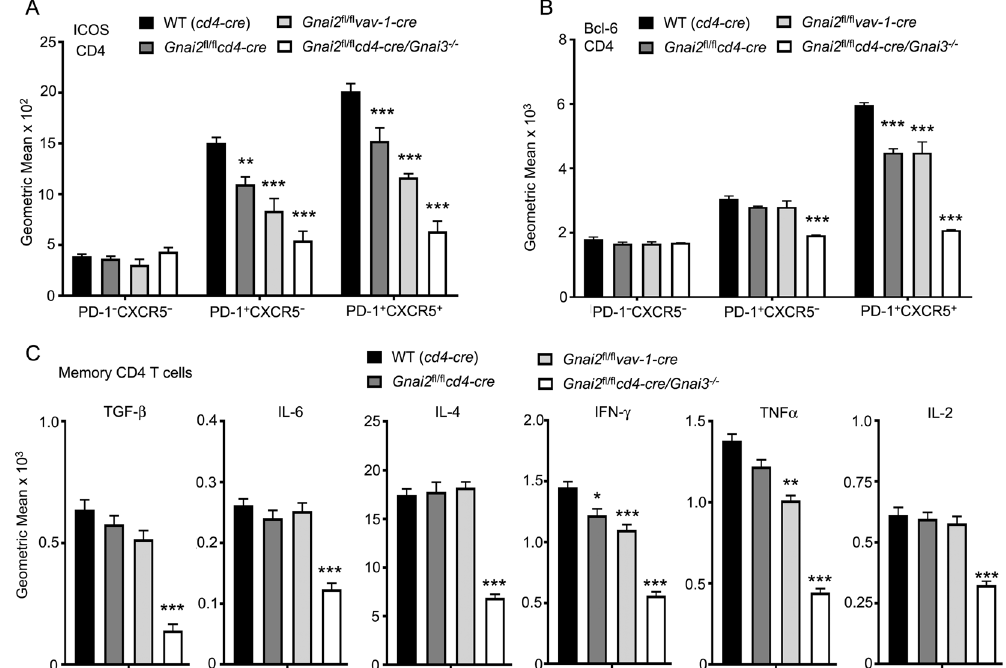
Figure 6. Characterization of CD4 Tfh cells and memory CD4 T cell cytokine production using cells from prepared from different mutant mice. ( A , B ) Flow cytometry to examine ICOS ( A ) and intracellular Bcl-6 ( B ) expression by different CD4 T cell subsets. Results are shown as geometric mean from 6 WT, 3 Gnai2 fl/fl vav1-cre , 6 Gnai2 fl / fl cd4-cre and 4 DKO mice. ( C ) Intracellular chemokine levels in memory CD4 T cells isolated from the spleens of WT, Gnai2 fl/fl vav1-cre, Gnai2 fl / fl cd4-cre and DKO mice. Shown are the geometric means of